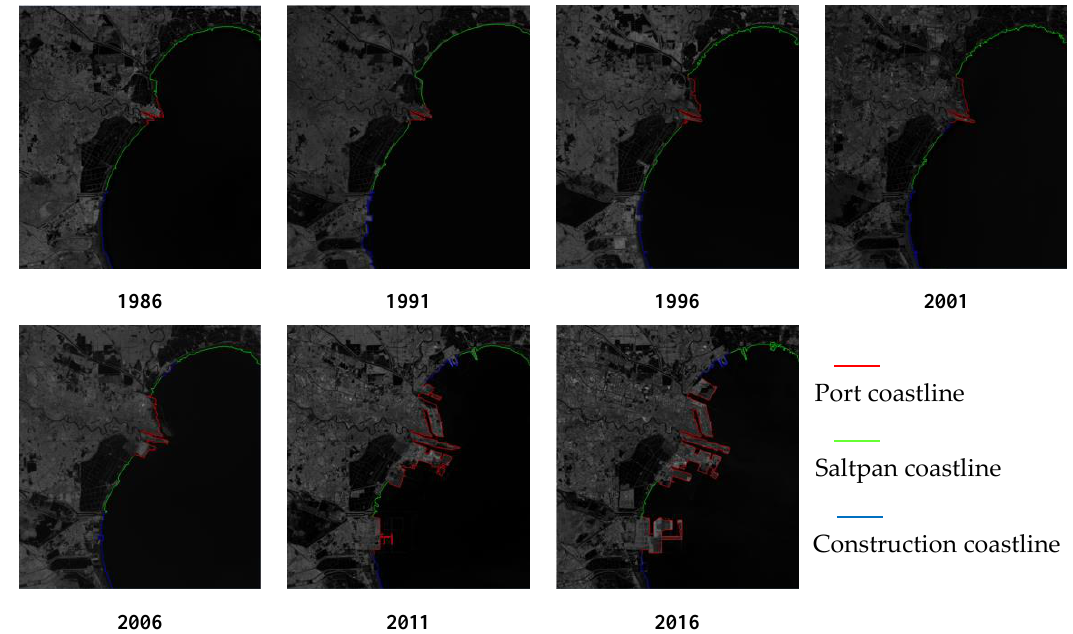
Figure 4. Automated subtype coastline determination by MFBSCD method from Landsat imagery in Tianjin,